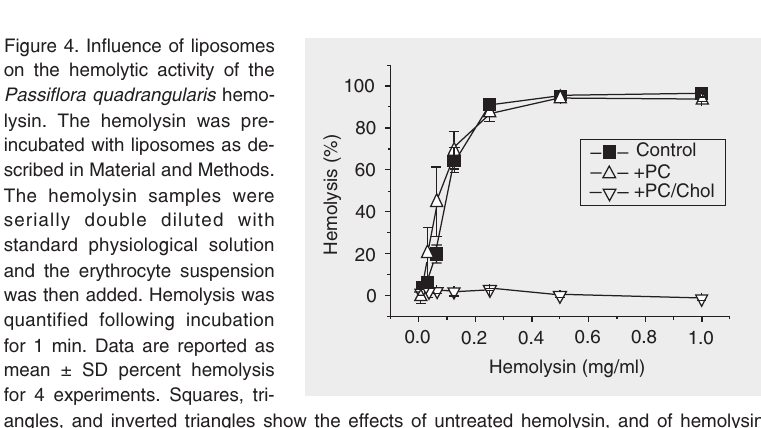
Figure 3. Concentration-de- pendent hemolysis by Passiflora quadrangularis hemolysin. He- molysis was quantified following incubation for 1 min. Data are reported as mean ± SEM per- cent hemolysis for 4 experi- ments in a double logarithmic plot. The SEM was <3%. Straight lines are least-squares fit. The slope value was 1.3 ± 0.1. All other conditions for the experiment are described in Ma- terial and Methods.